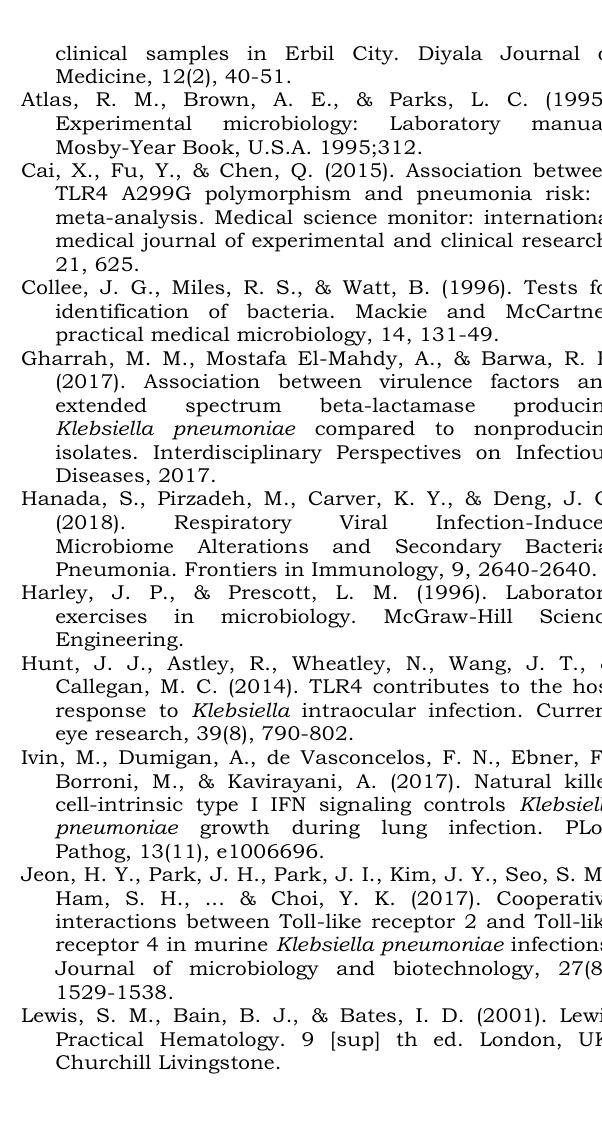
Fig. 10. The levels of TLR4 concentration according to patients with pneumonia and control sex groups